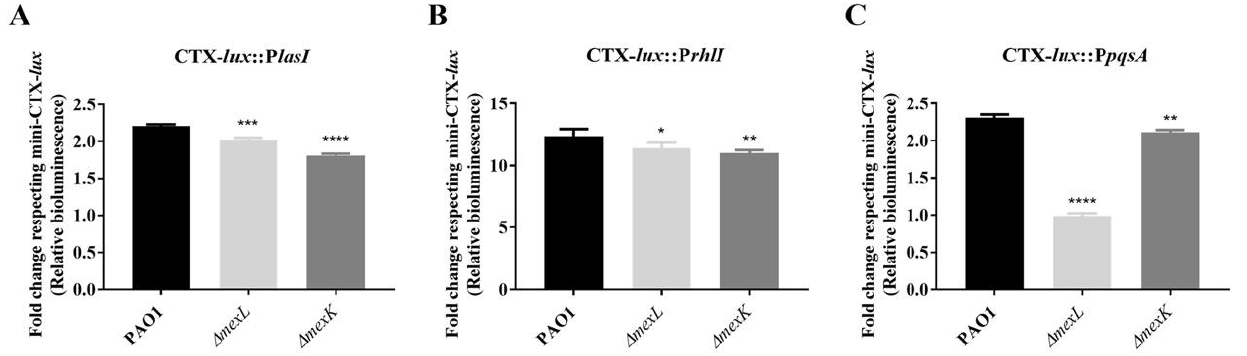
Figure 7. Analysis of the activation of promoters involved in QSSMs synthesis. Time-course of ( A ) P lasI , ( B ) P rhlI , and ( C ) P pqsA expression was analyzed in PAO1, ∆ mexL , and ∆ mexK strains growing in LB medium for 20 h, using a chromosomal insertion of the reporter construction of each promoter followed by the operon luxCDABE . The total area under the curve was quantified and is represented. As shown, luminesce driven by the pqsA promoter was strongly impaired in the strain that overproduces the MexJK efflux system. Values that are significantly different with respect to those obtained in the PAO1 strain by an unpaired two-tail t -test are indicated by asterisks as follows: * p < 0.05; ** p < 0.01; *** p < 0.001; **** p < 0.0001.